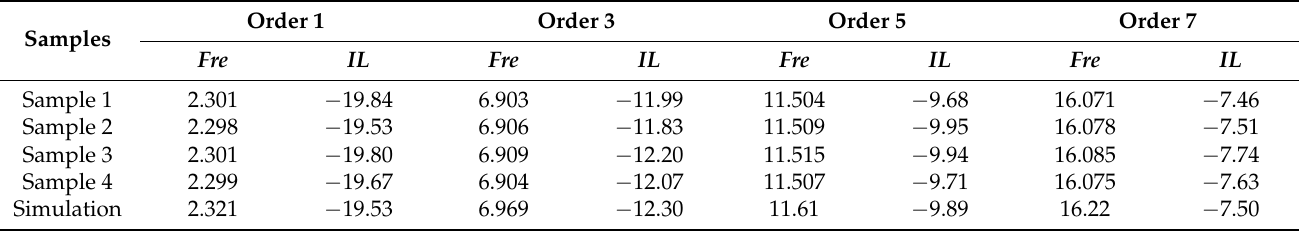
Figure 3. ( a ) The simulated frequency response of the proposed embedded resonator and ( b ) the measured frequency response of one embedded resonator sample. Table 1. The resonant frequencies ( Fre : GHz) and the corresponding insertion loss ( IL : dB) at these frequencies for the selected 4 samples in measurement and